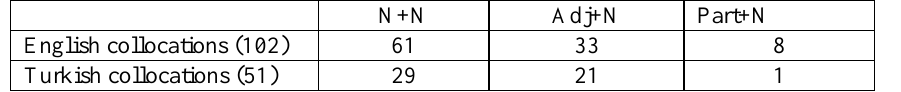
Table 1 – The number of metaphorical political collocations under study and their distribution by syntactical